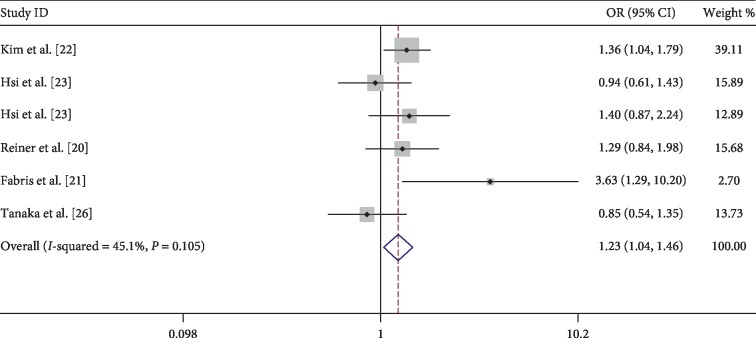
Forest of comparison: urolithiasis versus without urolithiasis and event: arteriosclerosis. OR value and CI adjusting potential confounding factors. OR: odds ratio; CI: confidence interval.